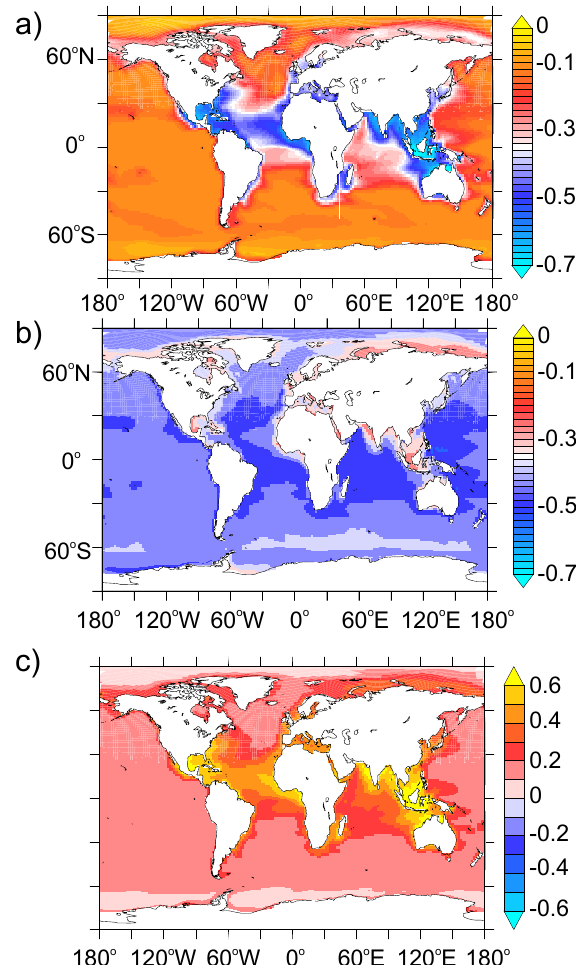
Fig. 8. The proportional change (i.e., (X fixlig – X varlig ) /X varlig ) in the proportion of the dFe pool (a) organically complexed, (b) present as bFe when bFe = Fe(II) + Fe(III) + FeL S and (c) present as bFe when bFe = Fe(II) + Fe(III) when ligands are assumed to be fixed at